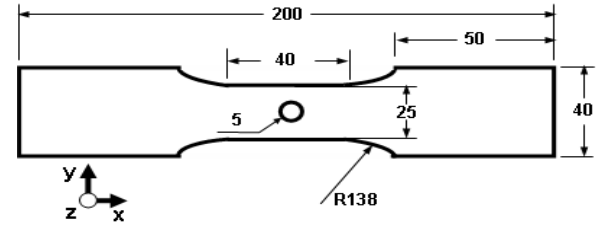
Figure 1: Geometrical model of fatigue specimen